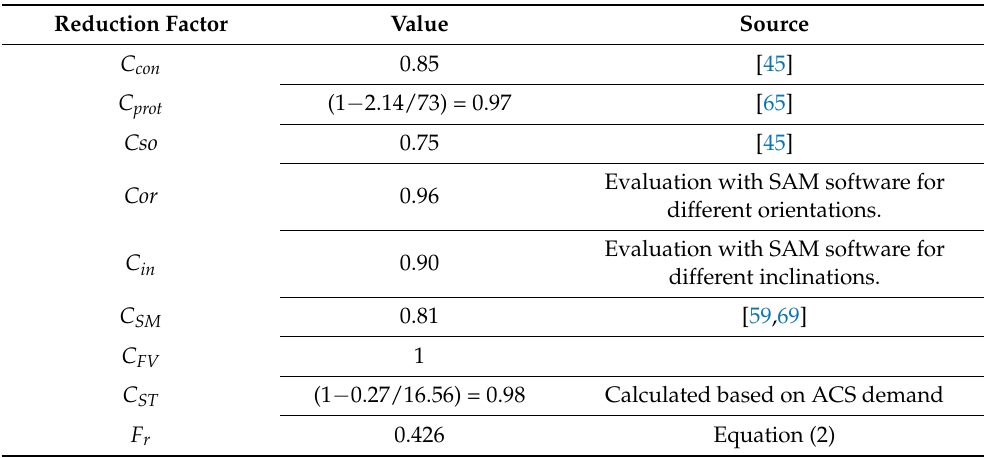
Table 6. The utilization factors used for the calculation of available roof surface.